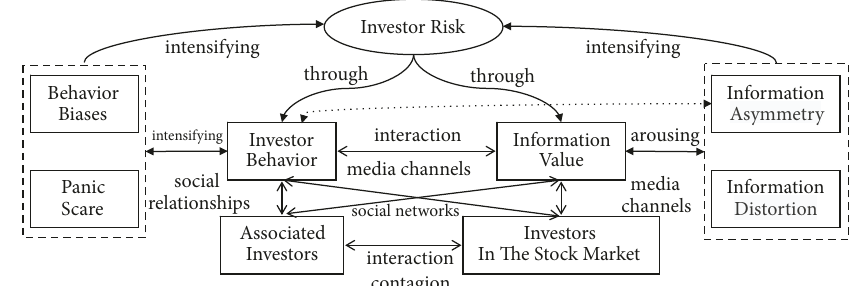
Figure 3: Information value, information asymmetry, and investor risk.